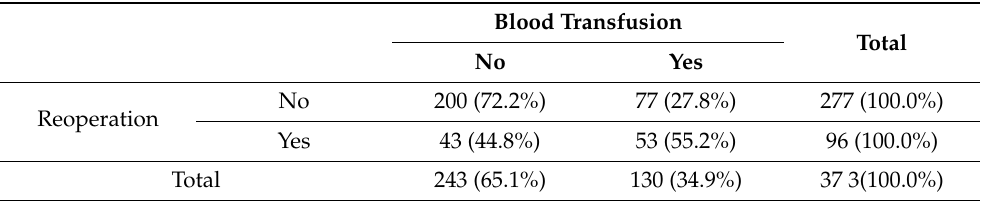
Table 1. Relationship between blood transfusion and reoperated